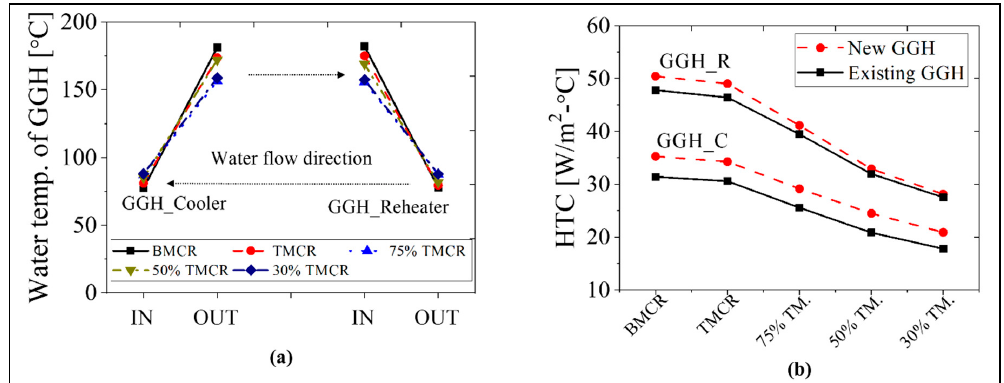
Figure 11. Water temperature at the inlet and outlet, and the HTC of the GGH for the new process based on the load conditions: ( a ) water temperature of the GGH and ( b ) HTC of the GGH.